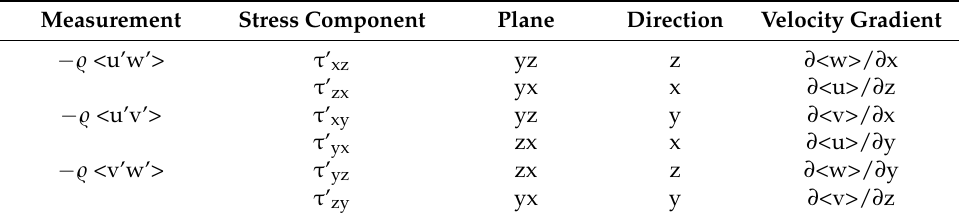
Table 1. Reynold Stress